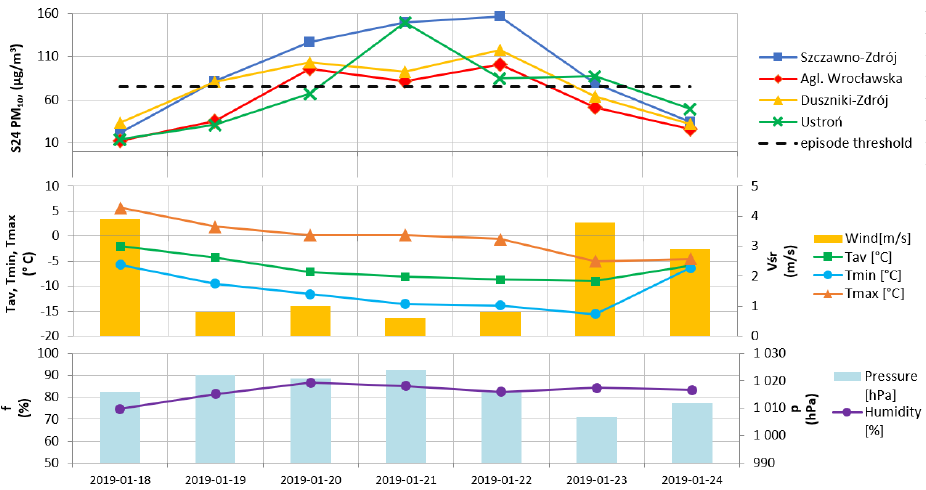
Figure 5. PM 10 24-h concentration at selected measuring stations and meteorological parameters in Jelenia Góra (Source: own study based on SEM data, [30,47]).